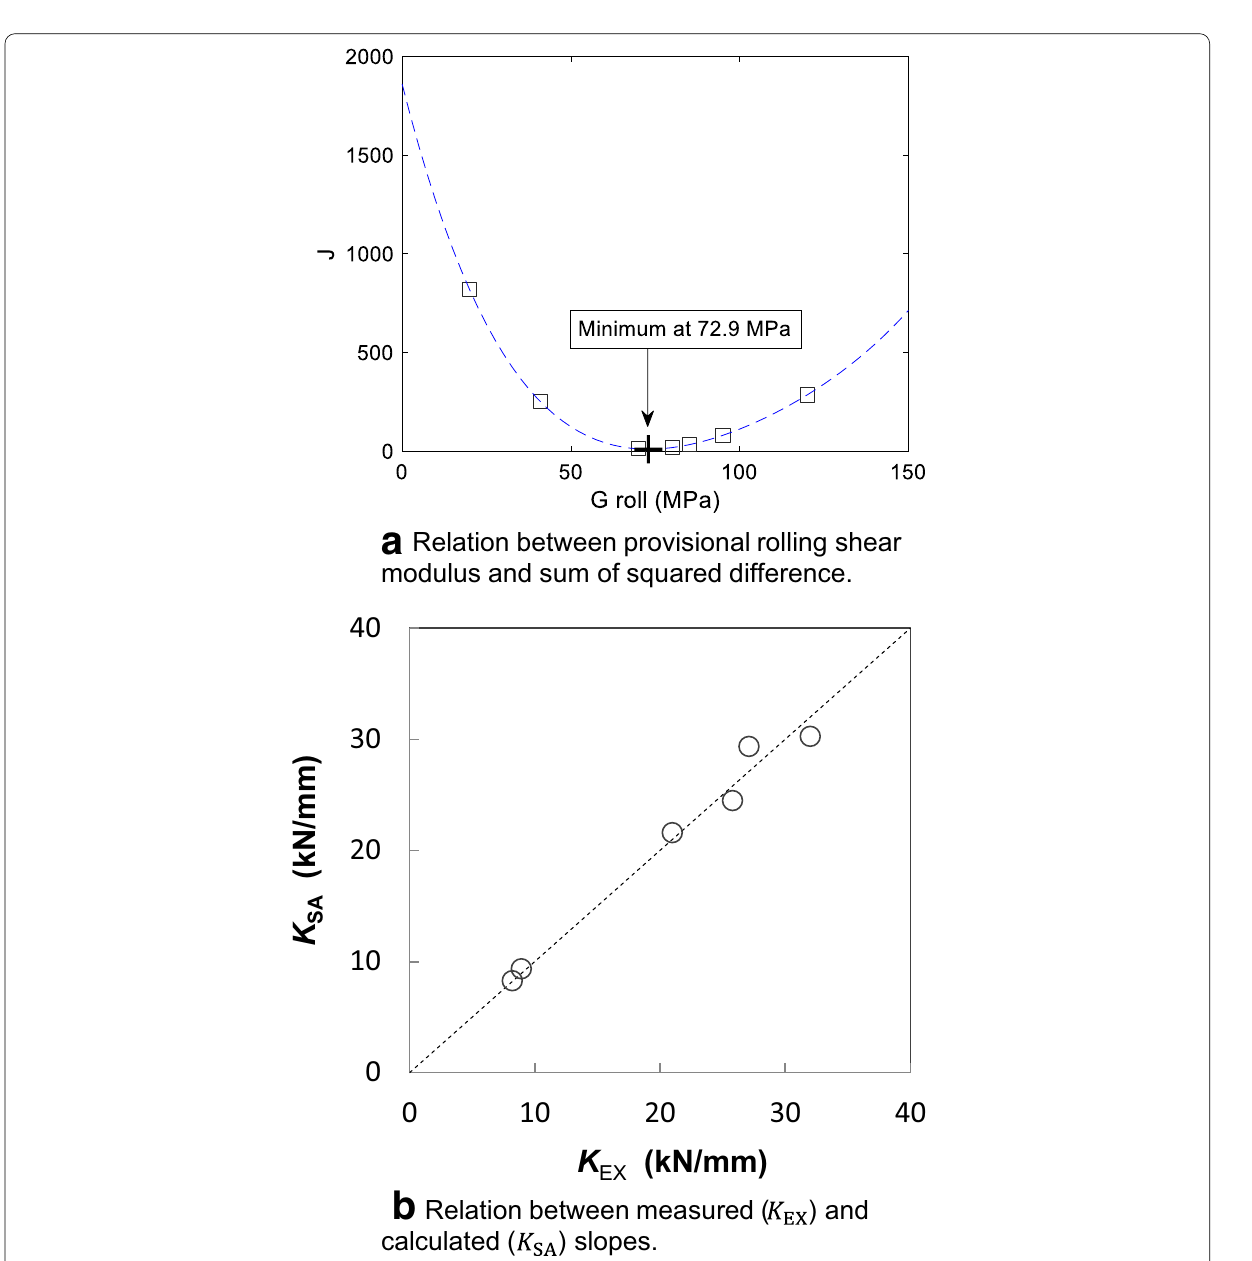
Fig. 9 Determination of shear modulus by comparing the slope of the load deflection curve. J : the sum of squared difference between measured slopes ( K EX ) and calculated slopes ( K SA ) of external force–deflection